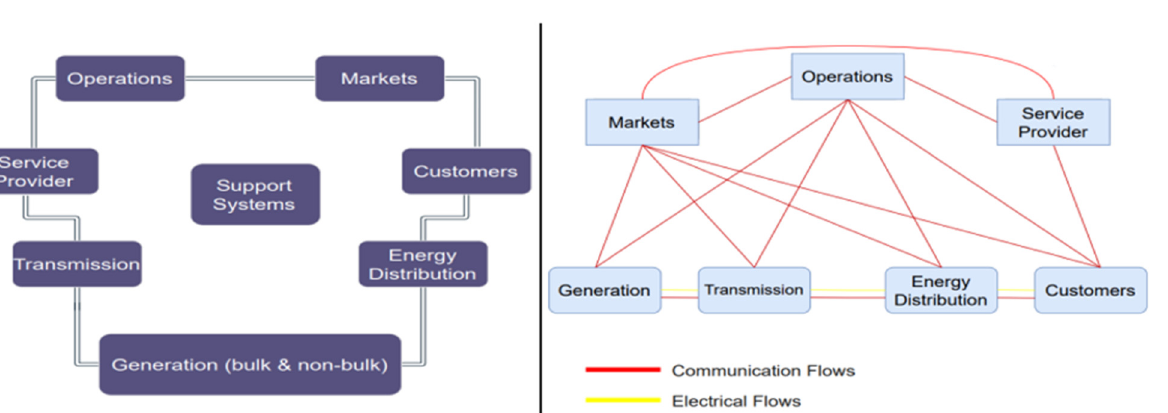
Figure 4. S mart grid domains and communication paths between smart energy grid domains.